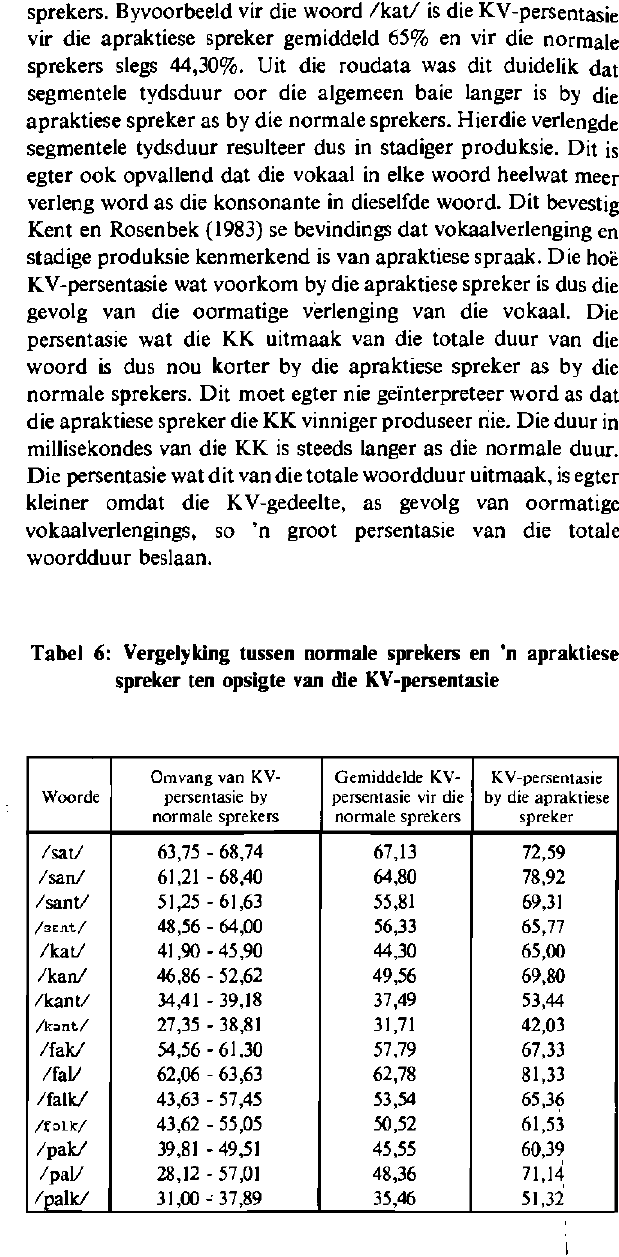
Tabel 5· Vergelyking tussen die normale sprekers en die apraktiese ' spreker ten opsigte van KV%-konstantheid oor 3 herhalings van dieselfde woord. Voorstelling deur middel van konstantheidsvariasie-waardes.